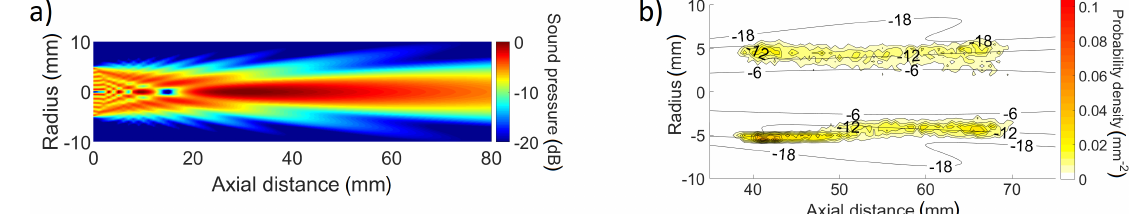
Figure 8. ( a ) Sound pressure field simulation based on [34]. ( b ) Detail with sound field in dB (contour